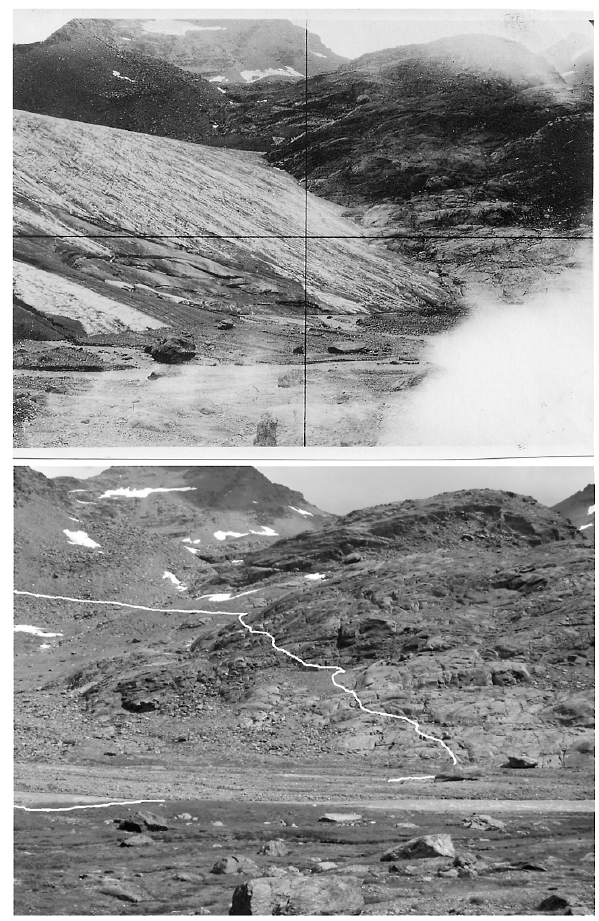
Fig. 2. Example of front position checking by identifying the glacier margin in the ground, as visible in old photographs (upper photo taken on 24 August 1923 (Desio, 1967), lower photo taken on 20 July